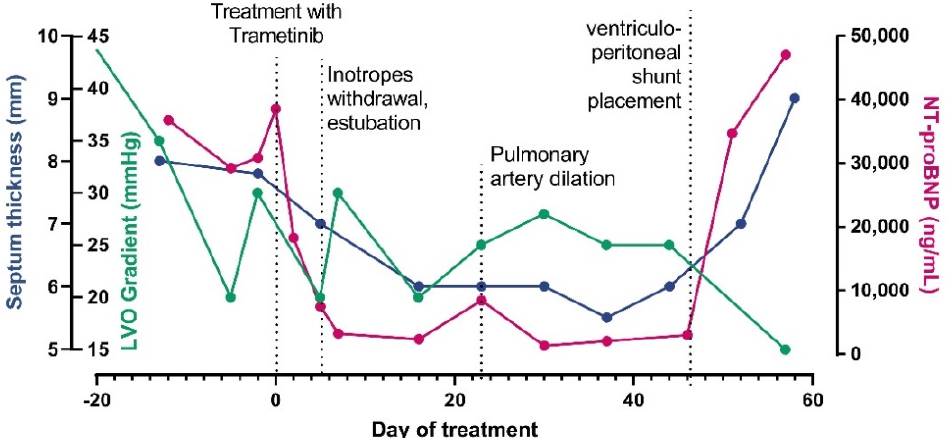
Figure 1. Treatment time course. The picture shows changes in nt-pro-BNP, Left Ventricular Outflow (LVO) gradient and septal thickness at ultrasound before and after treatment initiation and related to the major clinical events in our